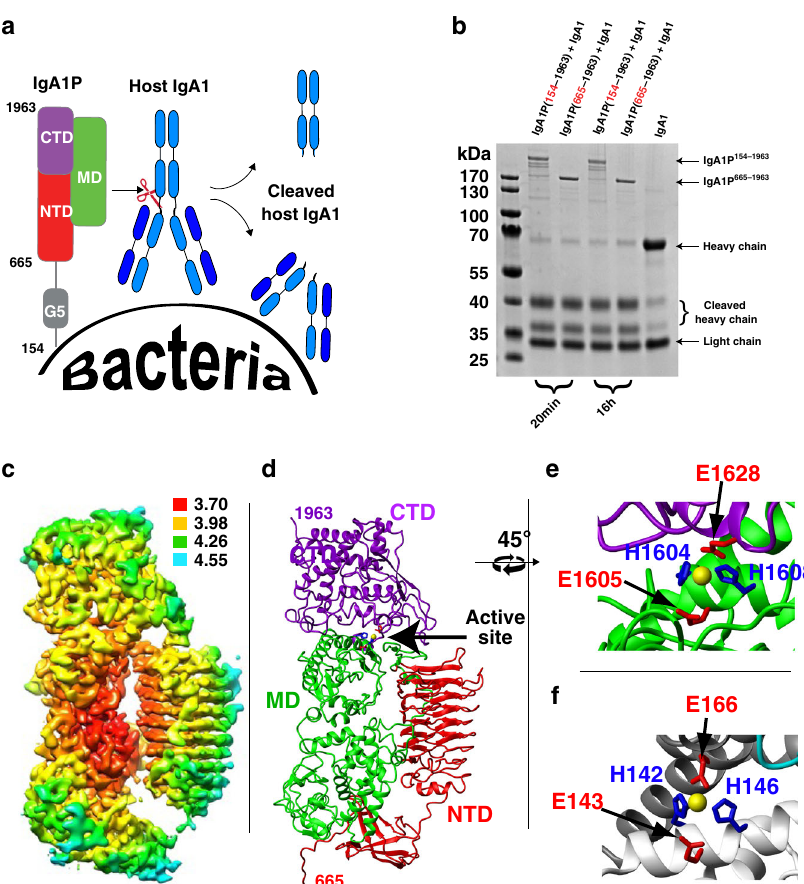
Fig. 1 Function and cryo-EM structure of the S. pneumoniae IgA1P. a The family of IgA1Ps cleave host IgA1 at its hinge region, separating the IgA1 Fc from its Fab and effectively masking bacterial cells with host IgA1 Fab. The general domain architecture of mature S. pneumoniae IgA1P consists of a fl exible N- terminal region (residues 154 – 664) attached to the bacterial cell wall, which includes a small G5 domain followed by a large C-terminal catalytic region (residues 665 – 1963) 21,22 . b S. pneumoniae IgA1P cleavage is similar between the mature IgA1P 154 – 1963 and isolated catalytic region of IgA1P 665 – 1963. Shown is one of two independent SDS-PAGE gel measurements. c 3D reconstruction of S. pneumoniae IgA1P (residues 665 – 1963) is colored according to the local resolution estimates (units in Å). The map was produced using Chimera 38 . d S. pneumoniae IgA1P ribbon structure highlights the tertiary structure (PDB ID: 6XJB). Domains are each color-coded along with the modeled Zn ion placed based on the superposition of catalytic residues with those found in thermolysin (yellow, arrow). The structure was modeled using Coot 32 . e Expansion of the S. pneumoniae IgA1P active site with H1604, E1605, H1608, and E1628 shown. f Expansion of the thermolysin active site in a similar orientation to panel E (PDB ID: 1TLX). Functionally homologous thermolysin and IgA1P catalytic residues have the same color coding between panels e and f